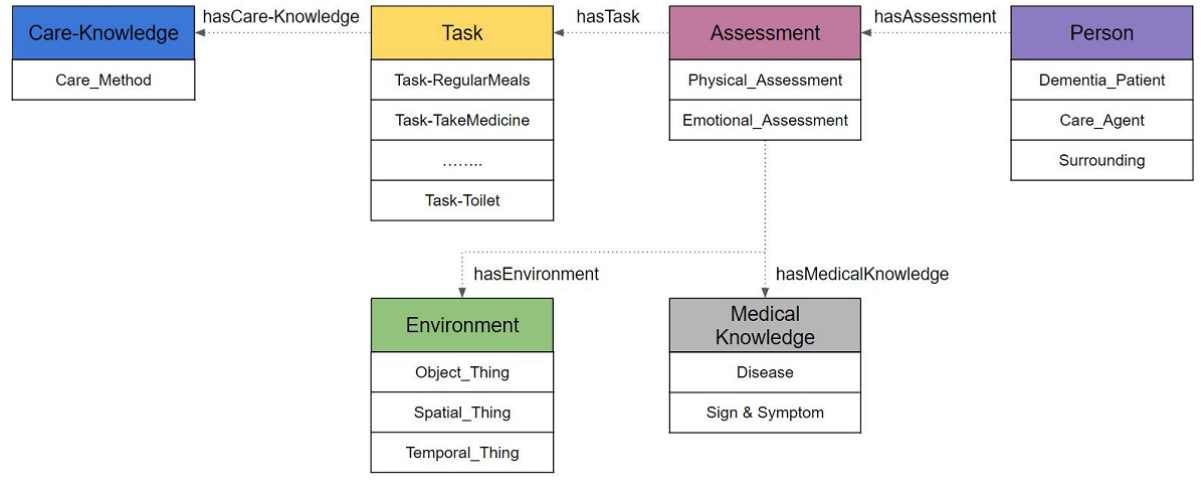
Figure 3. Upper classes of the proposed care ontology for persons with